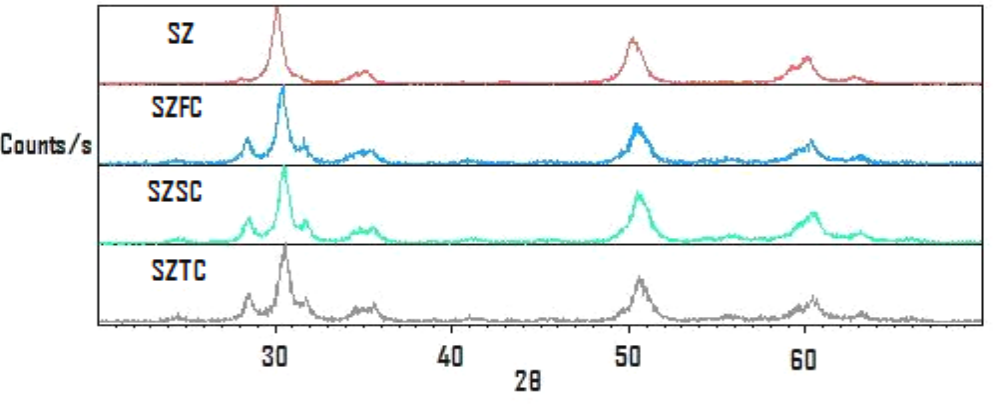
Figure 1. XRD traces of sulphated zirconia after reactivation cycles.